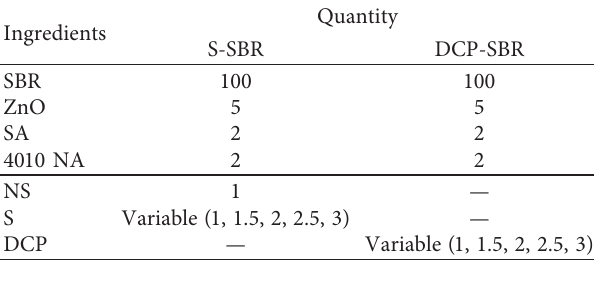
Table 1: Formulations in parts per hundred rubber